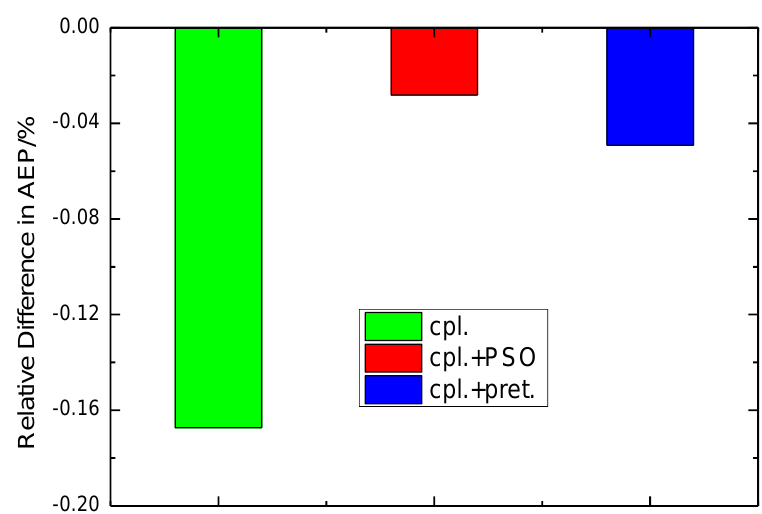
Figure 6. The relative difference in annual energy production (AEP) compared to the ucpl. Case.